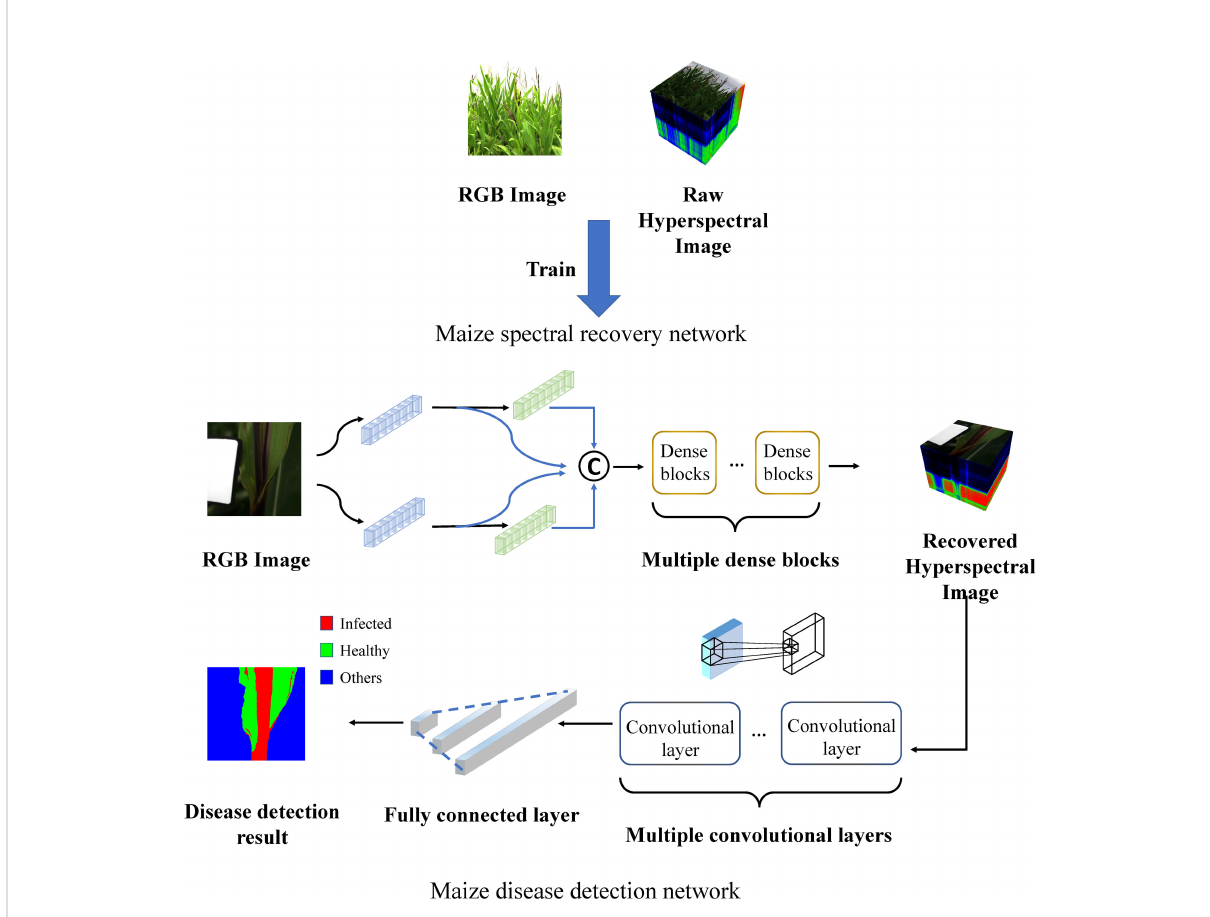
FIGURE 2 Schematic diagram of the overall maize spectral recovery and disease detection network